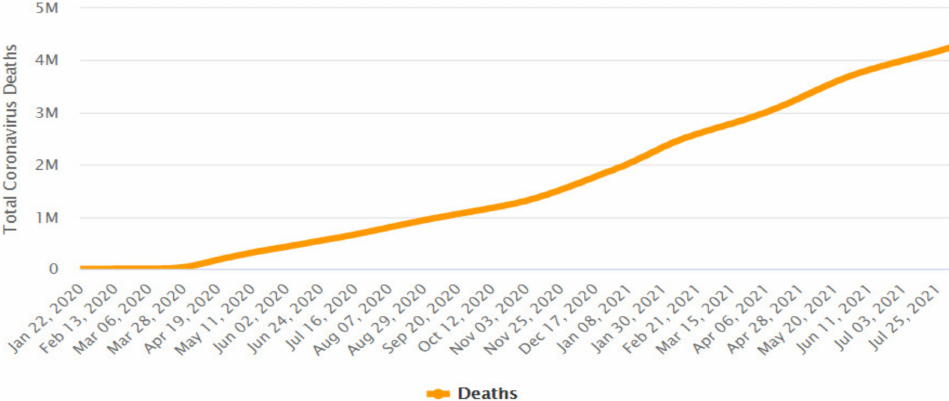
Figure 2. Total cumulative count of deaths caused by coronavirus (4,240,374) worldwide. Period: